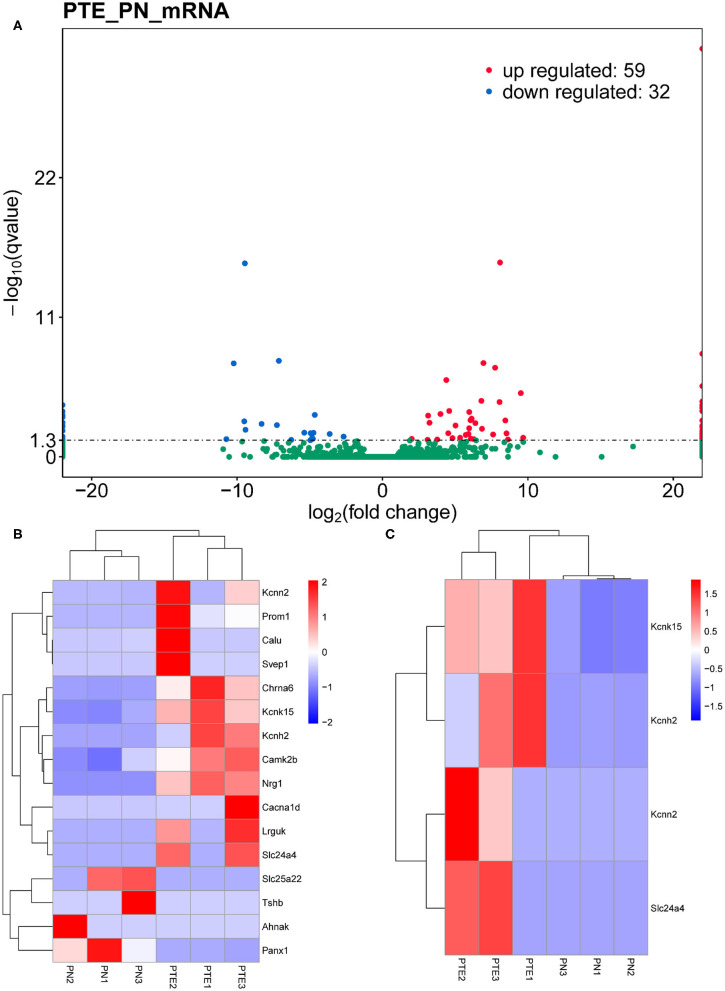
mRNA transcriptome analysis in rat frontal lobe by RNA sequencing (RNA-Seq). (A) A volcano plot of RNA-seq transcriptome data displays gene expression values of PTE rats compared with those of sham rats. Significantly differentially expressed genes (adjusted P-value <0.05) are highlighted in red (upregulated) or blue (downregulated). Non-differentially expressed genes are highlighted in green. n = 6. (B) Heat map of 12 significantly upregulated and four significantly downregulated ion channel-related genes in PTE rats compared with sham rats. (C) Heat map of four significantly upregulated potassium channel-encoding genes in PTE rats compared with sham rats. Adjusted P-value <0.05; n = 6.